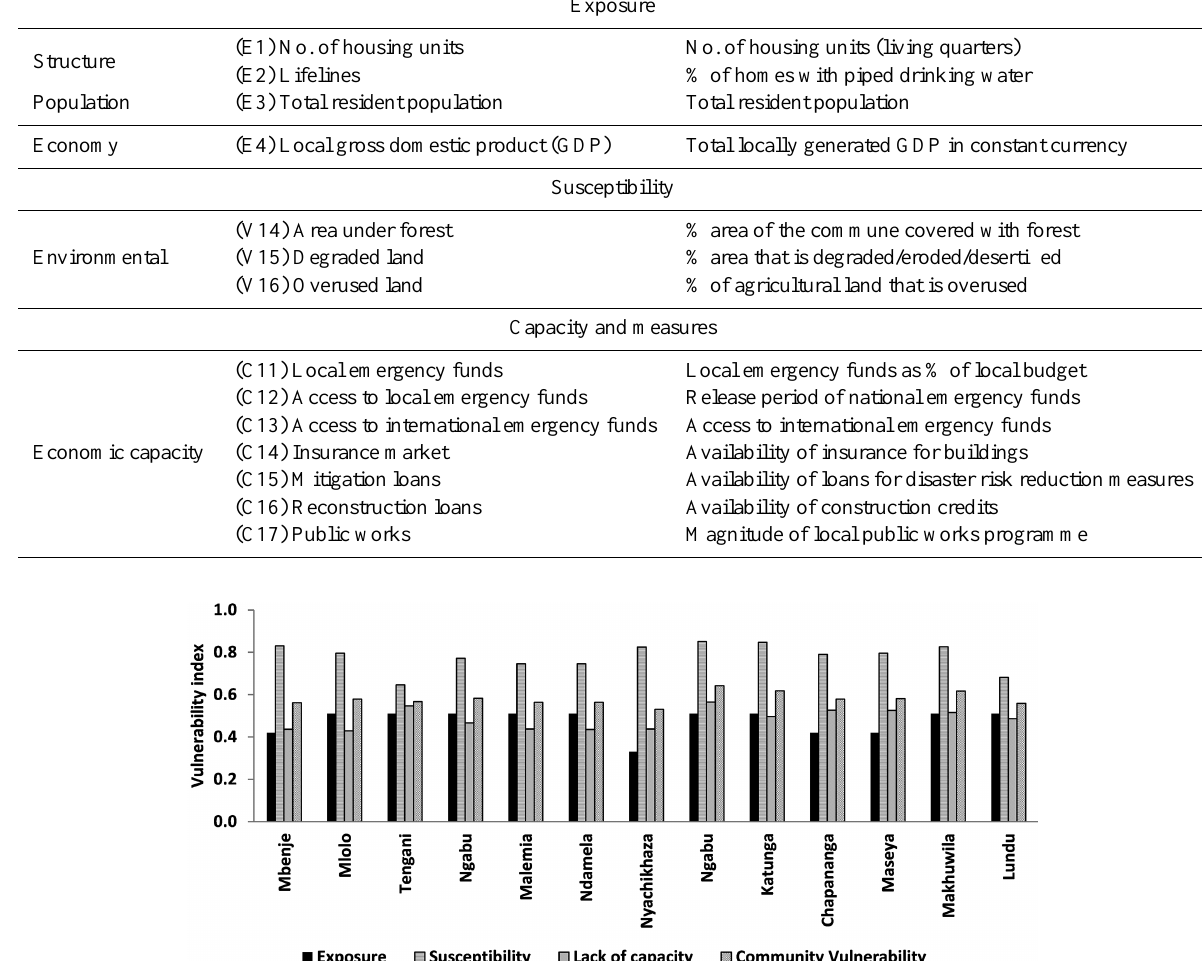
Figure 2. Vulnerability magnitudes from exposure, susceptibility and a lack of capacity across